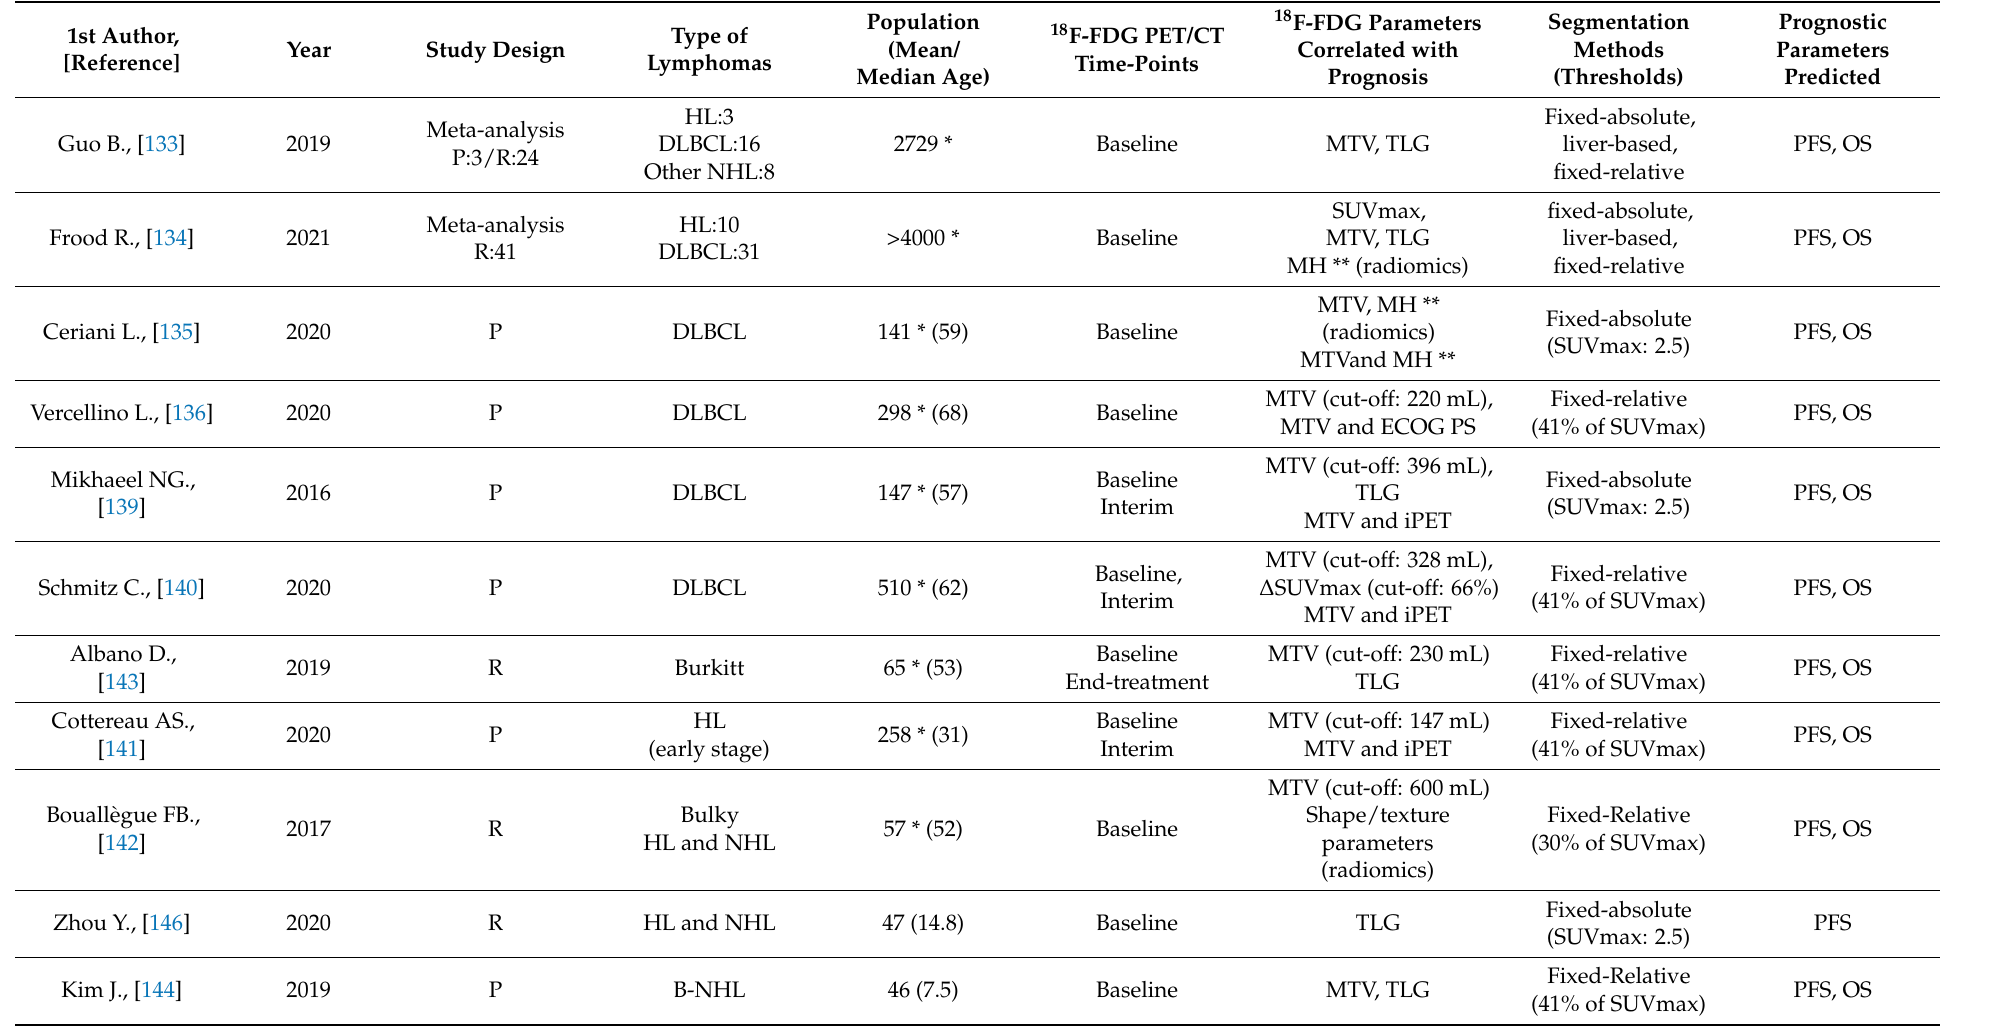
Table 2. Summary of observational 18 F-FDG PET/CT studies in lymphomas, including eight studies in pediatric